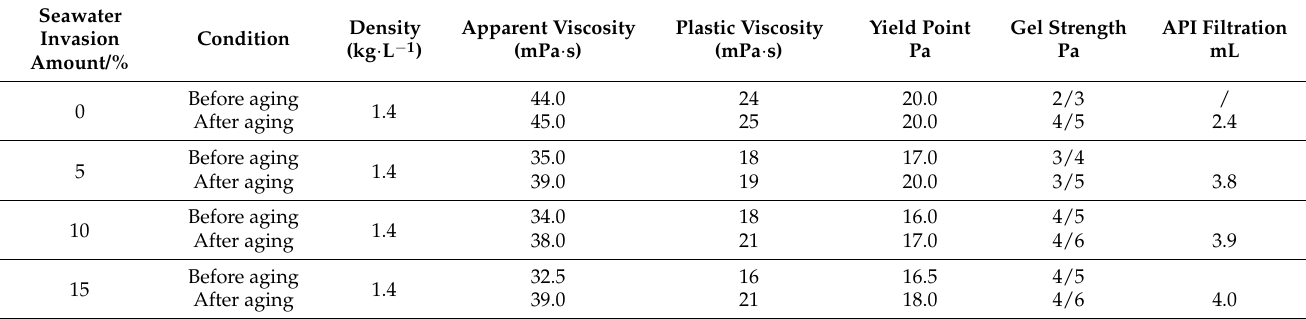
Table 6. Evaluation of anti-seawater pollution capability between before/after optimization of solid-free organic salt drilling